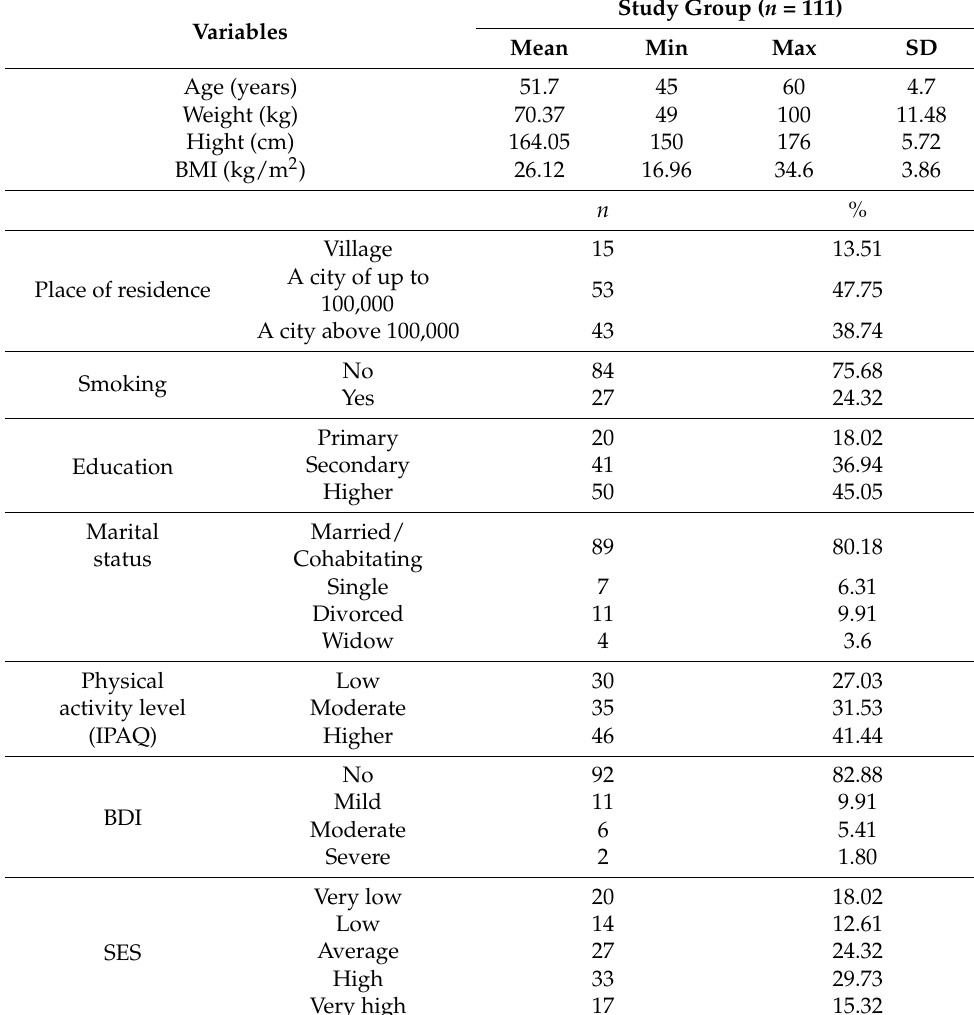
Table 1. Characteristics of all